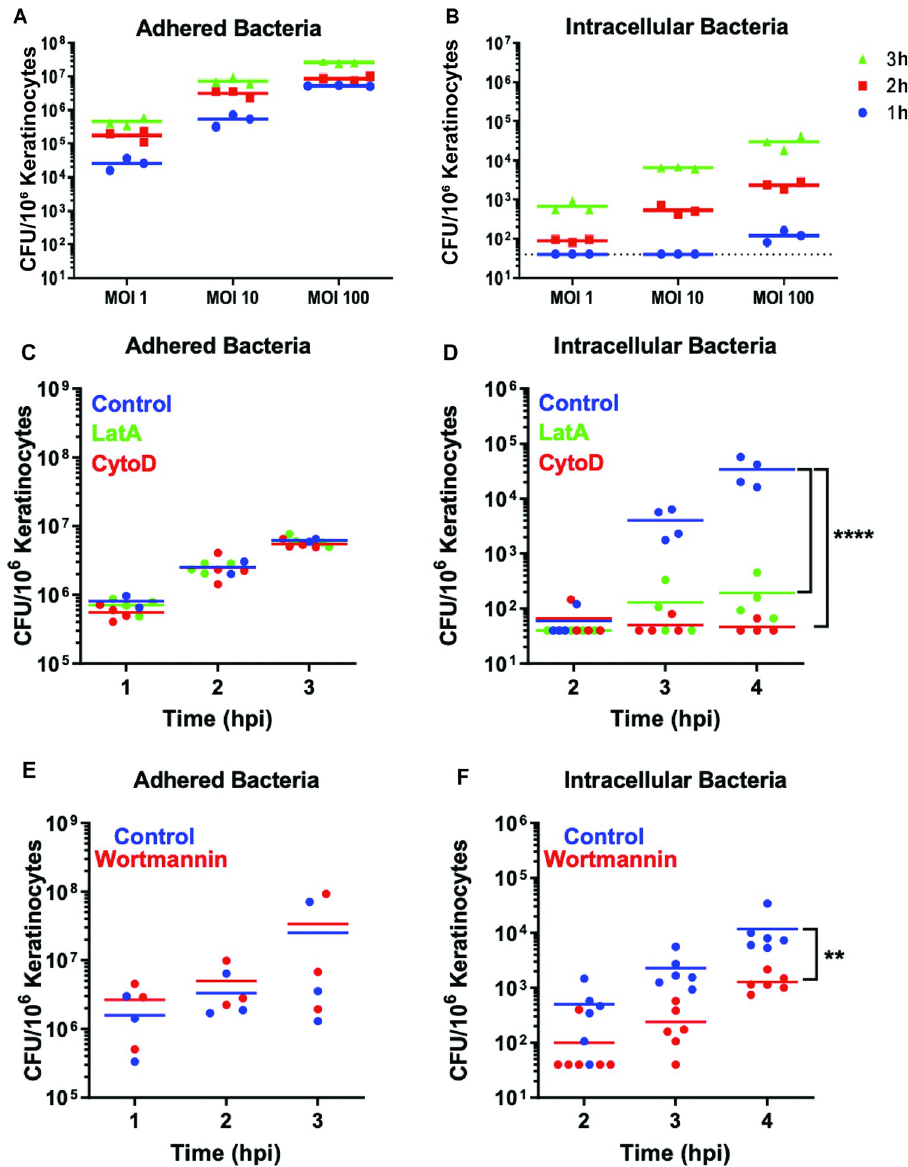
Fig 2. Time and dose-dependent increase of intracellular E . faecalis OG1RF with keratinocytes, following actin polymerization-dependent entry, in vitro . (A,B) 10 6 keratinocytes were infected with E . faecalis OG1RF at the indicated MOI for 1, 2, or 3 h, each followed by another 1 h of antibiotic treatment to eliminate extracellular bacteria. Infected host cells were washed once, lysed, and intracellular CFU enumerated. Solid lines indicate the mean CFU/well from a total of 3 independent experiments. Dashed black line indicates the limit of detection of the assay. (C-F) Keratinocytes were pre-treated with actin inhibitors cytochalasin-D (CytoD 1 μ g/ml), latrunculin A (LatA 0.25 μ g/ml), or PI3K inhibitor wortmannin (0.1 μ g/ml) for 0.5 h, followed by E . faecalis infection at MOI 100 for 1, 2 or 3 h. Following three PBS washes, cells were lysed and associated adhered bacteria enumerated immediately after infection; or, to quantify intracellular CFU, the initial infection period was followed by 1 h antibiotic treatment, for a total of 2, 3 or 4 hpi, prior to lysis and enumeration. (C,E) Adherent or (D,F) intracellular bacteria were enumerated at the indicated time points (only significant differences are indicated). Solid lines indicate the mean for each data set of at least 3 independent experiments. (D) ���� p < 0.0001 2 way ANOVA, Tukey’s multiple comparisons test. (F) �� p < 0.01 2 way ANOVA, Sidak’s multiple comparisons test. (See S1 Fig for data related to antibiotic killing efficiency. See S1 Table for data related to drug cytotoxicity).